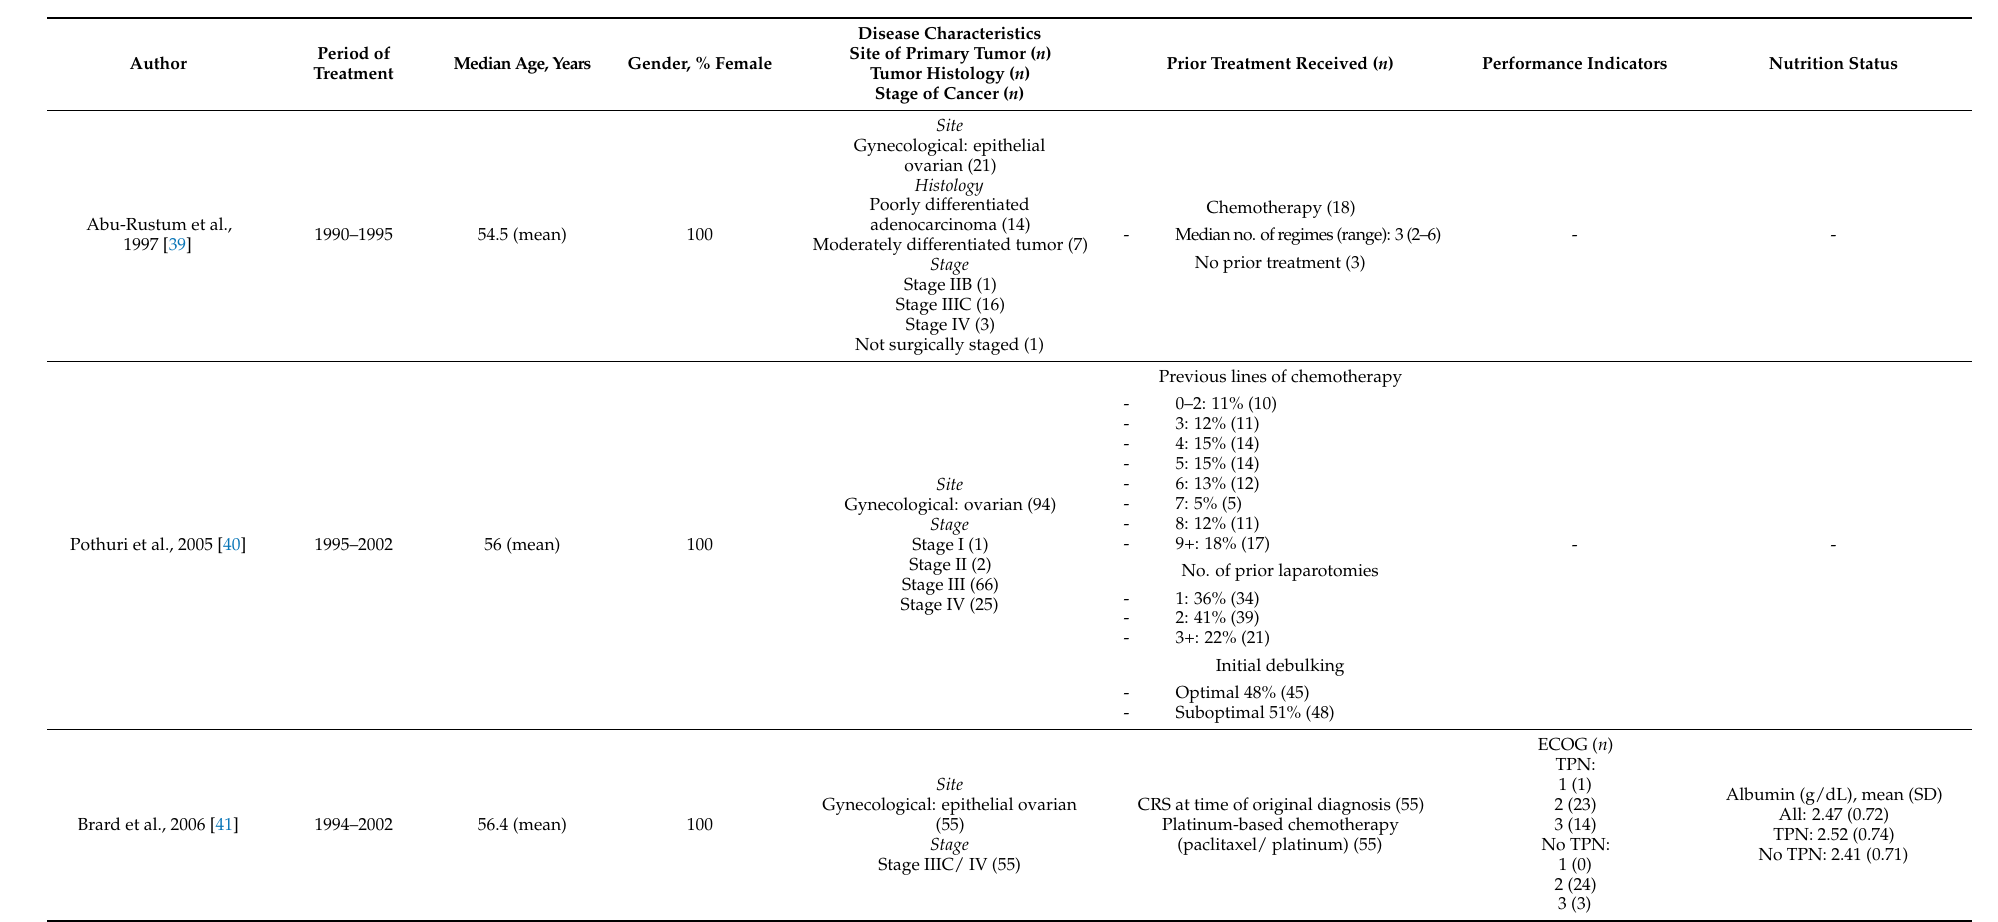
Table 2. Characteristics of all patients included in qualitative analysis ( n =